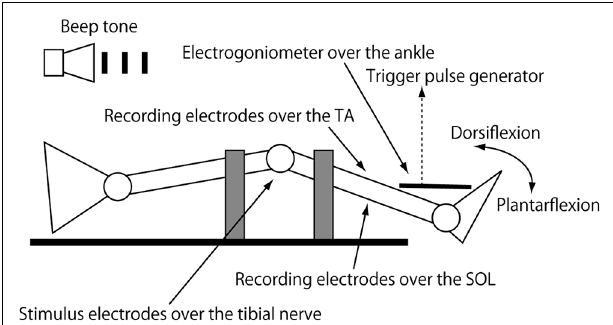
FIGURE 1 | Cartoon diagram of the experimental setup. Gray squares indicate bands bracing the thigh and thin to the table.The right knee is in the semiflexed position by placing the thigh and shin over the